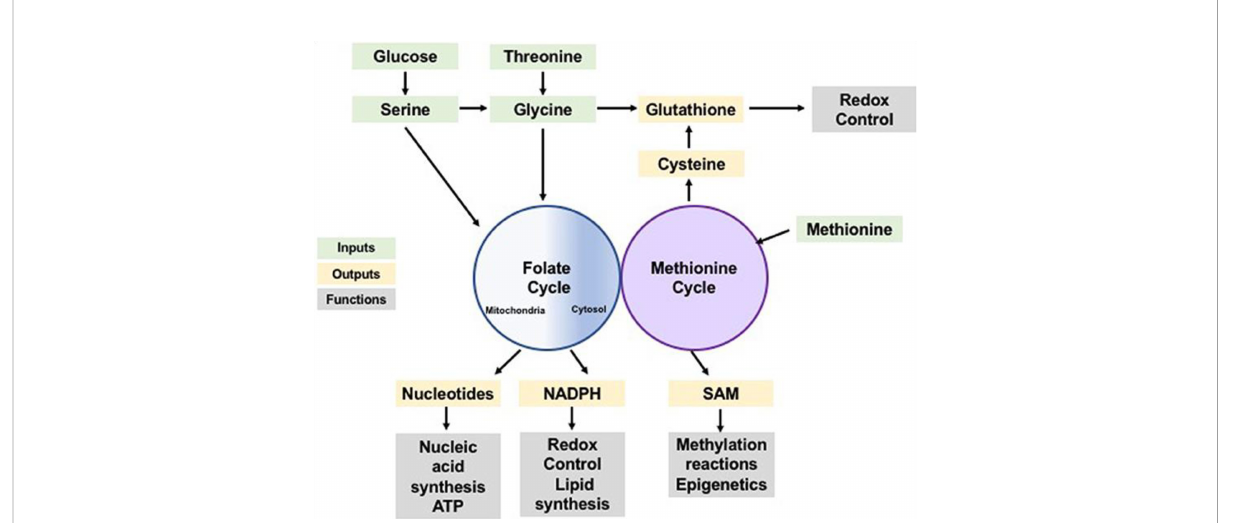
FIGURE 2 One-Carbon Metabolism is a Normal Cellular Activity of Integrating Nutrients and Availability. Note. Amino acids and glucose are inputs of the methionine and folate cycles (represented by the green color) which contribute one-carbon units that can be utilized in the anabolic synthesis of various building blocks and co-factors (represented by the yellow color) alongside reducing species. The products of these processes perform various biological functions (represented by the grey color), including biosynthesis of biomolecules, modulation of reduction-oxidation reaction, sustaining homeostasis within the cells, and post-translational modi fi